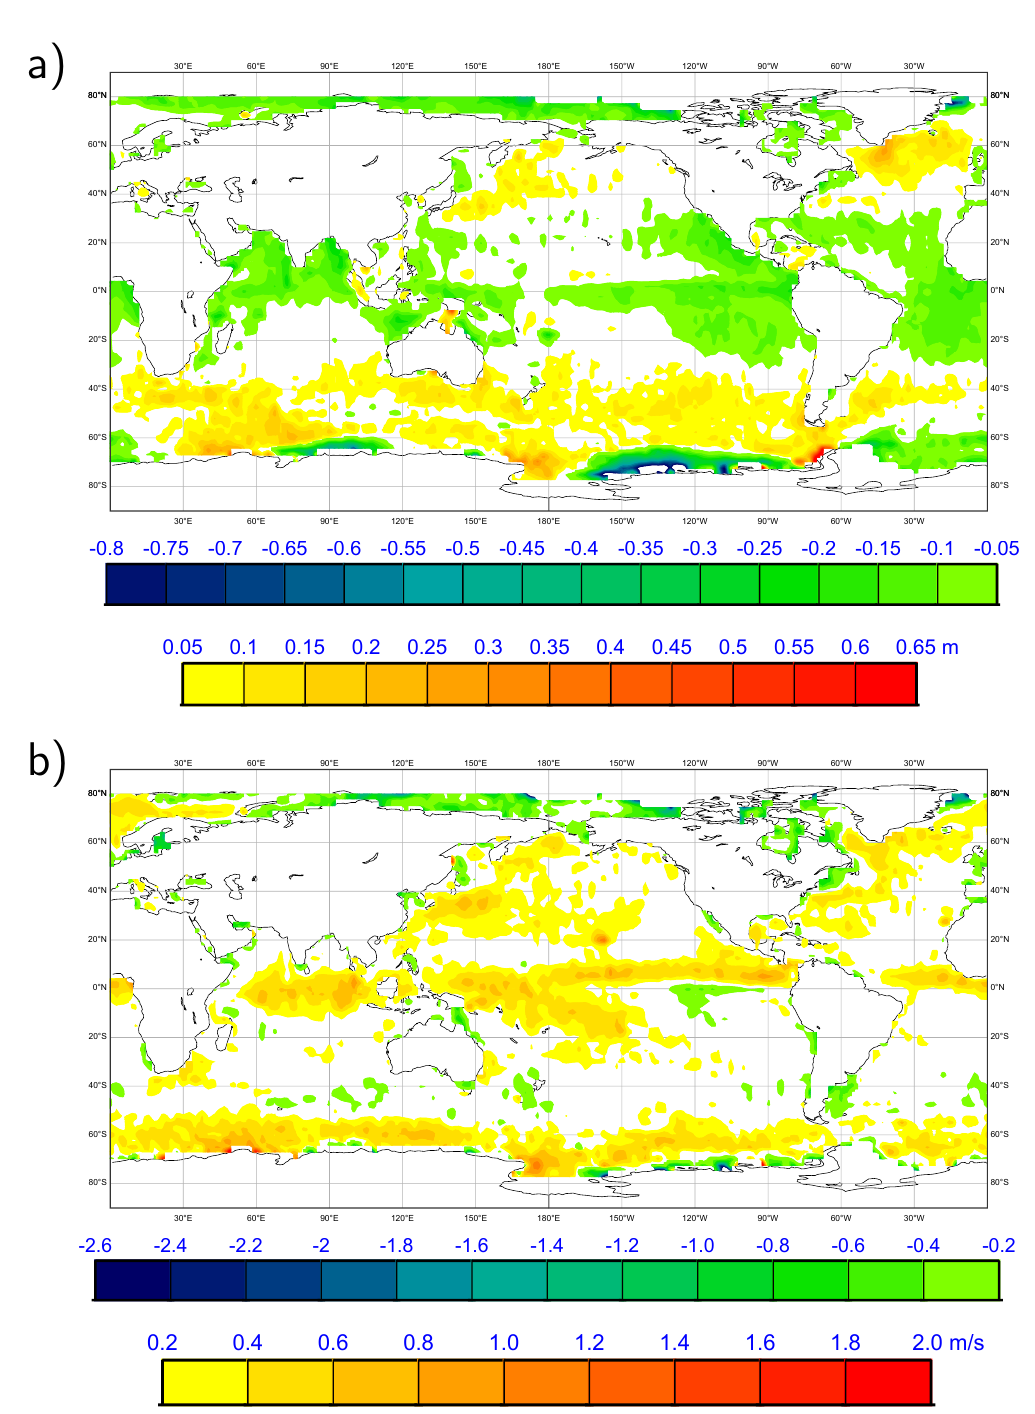
Figure 16. Geographical variation in S3A bias with respect to a model. ( a ) Wave height ( b ) Wind